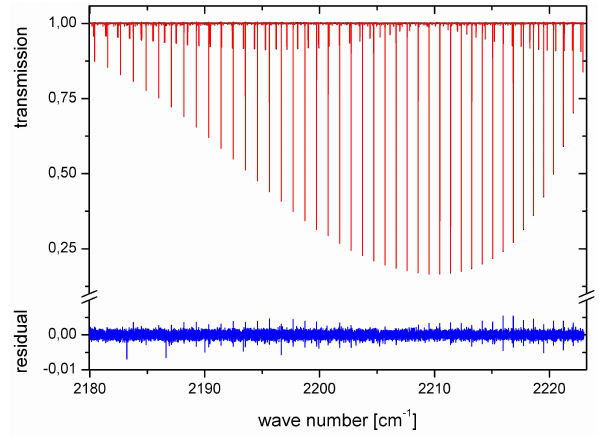
Fig. 11. The spectrum taken with cell C2 on 22 October 2011 (black), superimposed the synthetic spectrum fitted by LINEFIT is shown (red), blue: